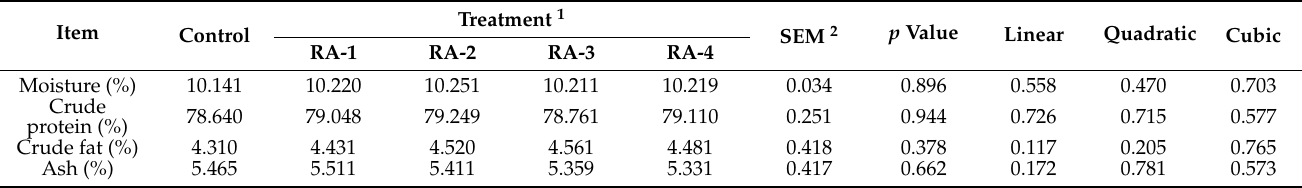
Table 6. The effect of dietary supplementation with rosmarinic acid (RA) on muscle proximate composition of broilers.